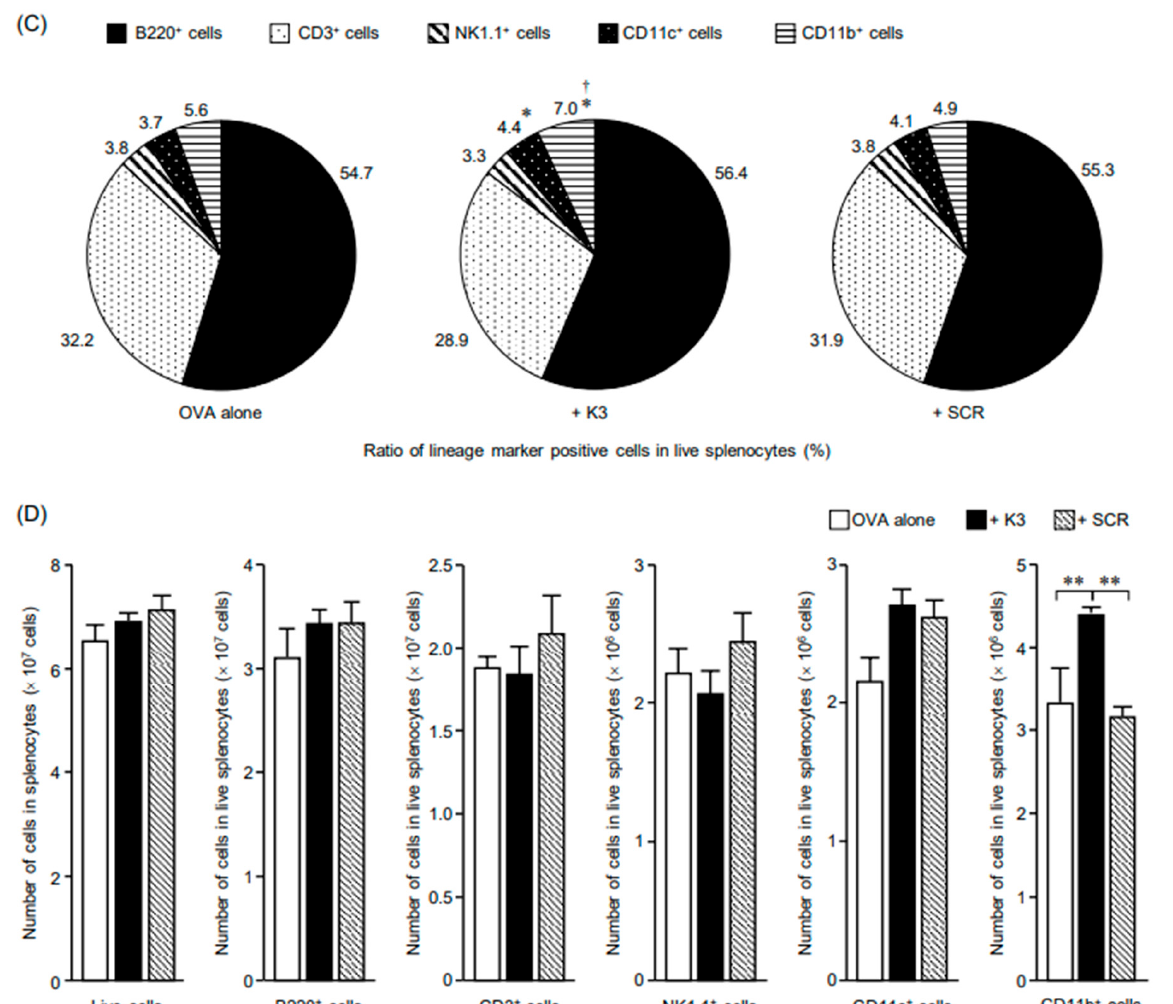
Figure 2. Population analysis of various immune cell subsets on primary immune response after K3 administration. C57BL/6 mice were immunized using the ovalbumin self-dissolving microneedle patch (OVA- sdMN) and K3-loaded hydrophilic gel patch (HG) methods with OVA, OVA + K3, or OVA + scramble (SCR). After 3 d, the ratio and the number of lineage marker-positive (B220, CD3, CD11b, CD11c, NK1.1) cells in draining lymph nodes (dLNs) ( A , B ) and the spleen ( C , D ) were analyzed via flow cytometry. ( A , C ) Ratios of the lineage marker-positive cells are expressed as the mean of the results obtained from three mice (Tukey’s test, * p < 0.05, ** p < 0.01 versus OVA alone, † p < 0.05, †† p < 0.01, versus +SCR). ( B , D ) The number of cells is expressed as the mean ± SE of results from three mice (Tukey’s test, * p < 0.05, ** p < 0.01).